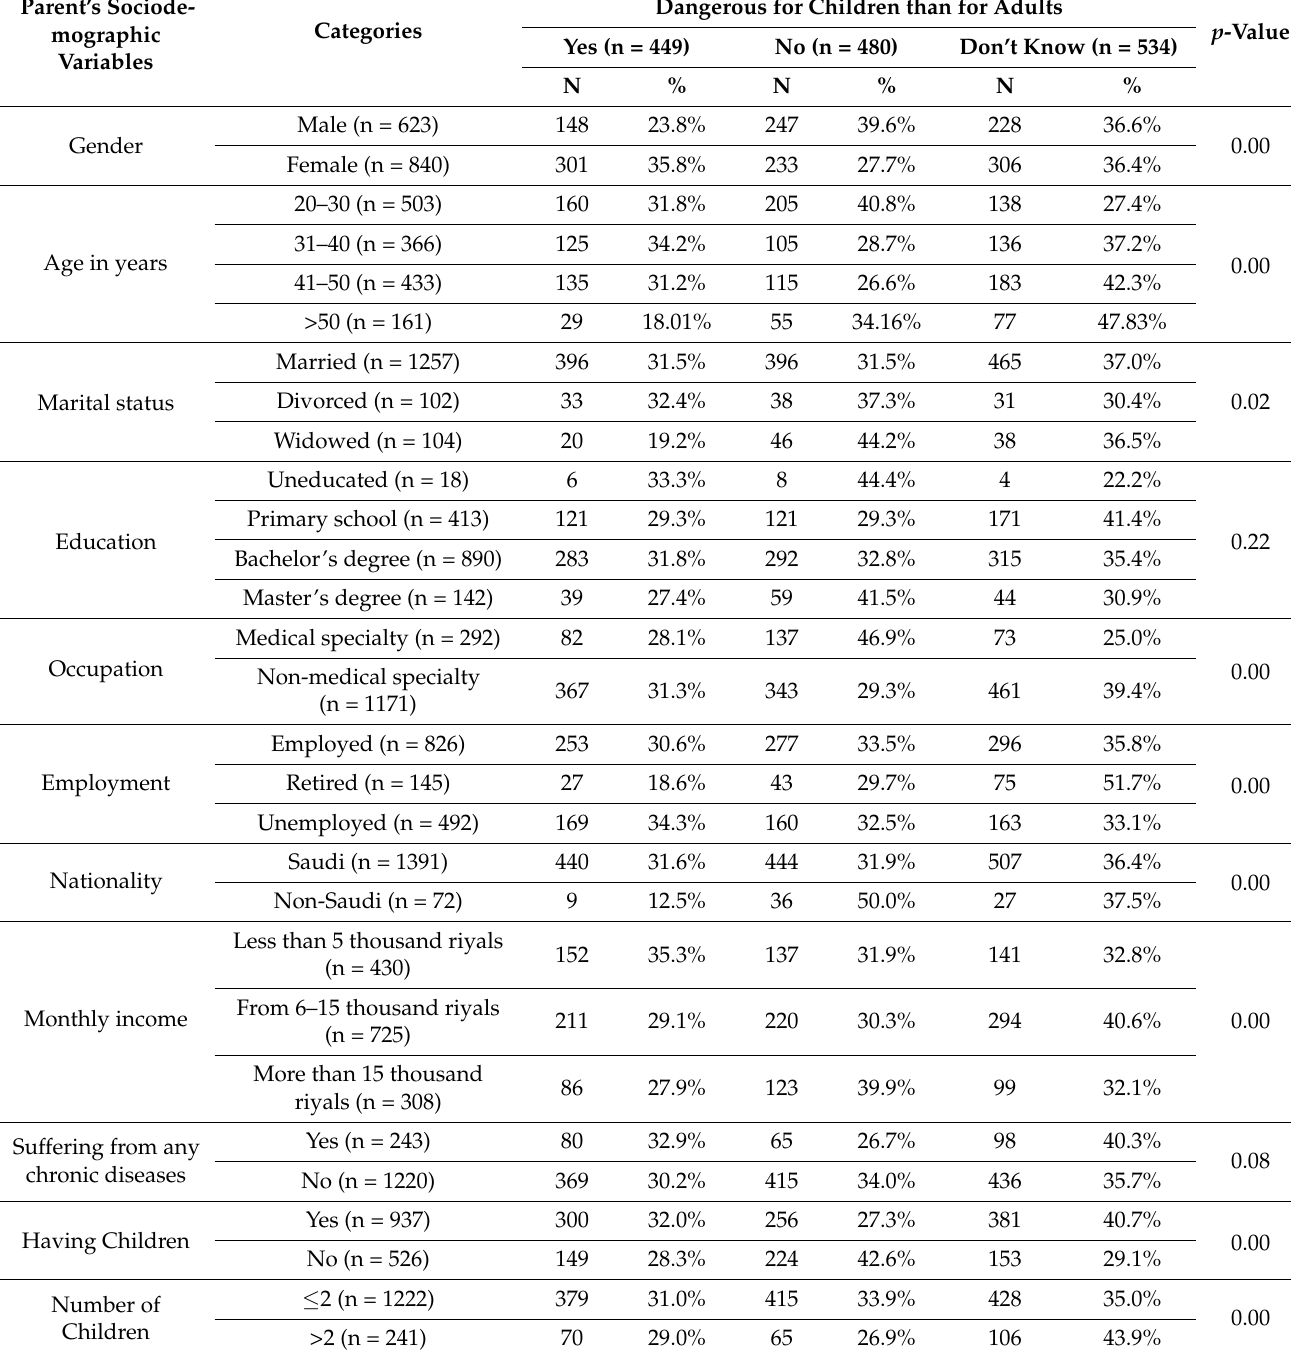
Table 1. Association between sociodemographic variables and parent’s concern toward children’s